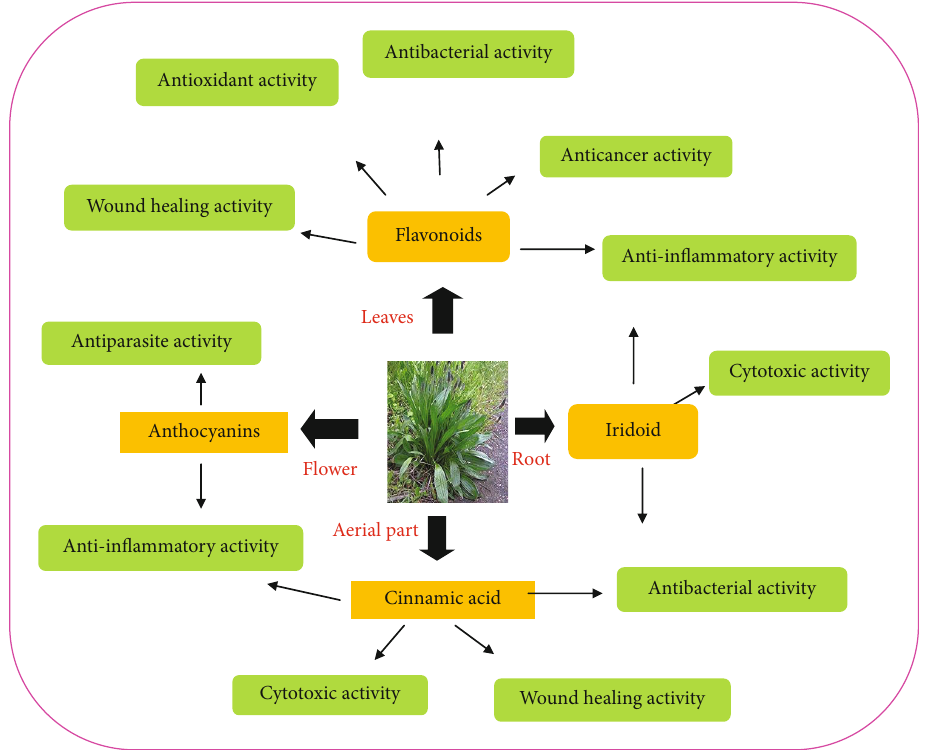
Figure 1: Biological activity of P. lanceolate